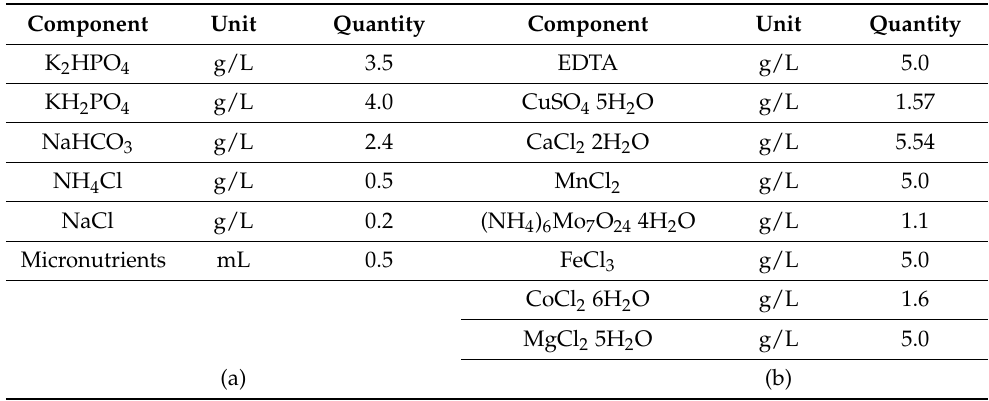
Table 2. (a) Composition of synthetic wastewater used in nitrification, (b) composition of micronutrients. Component Unit Quantity Component Unit